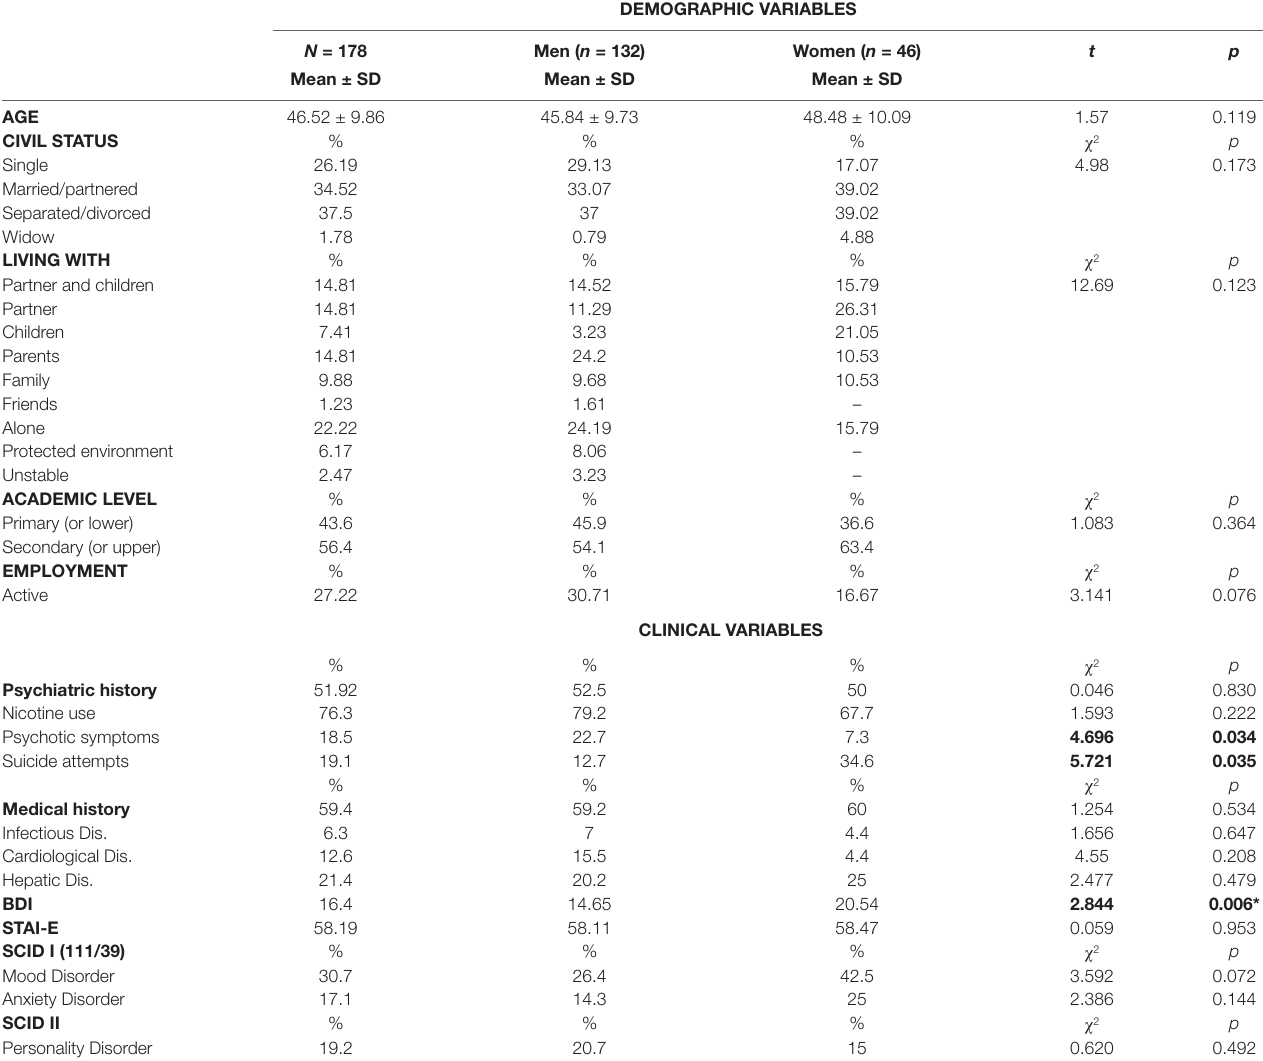
TABLE 1 | Demographic, clinical, and psychiatric variables and diagnoses of the sample.